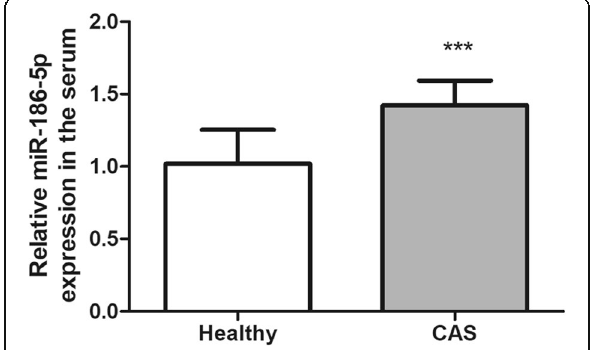
Fig. 1 Serum level of miR-186-5p was increased significantly in asymptomatic CAS patients. *** P <